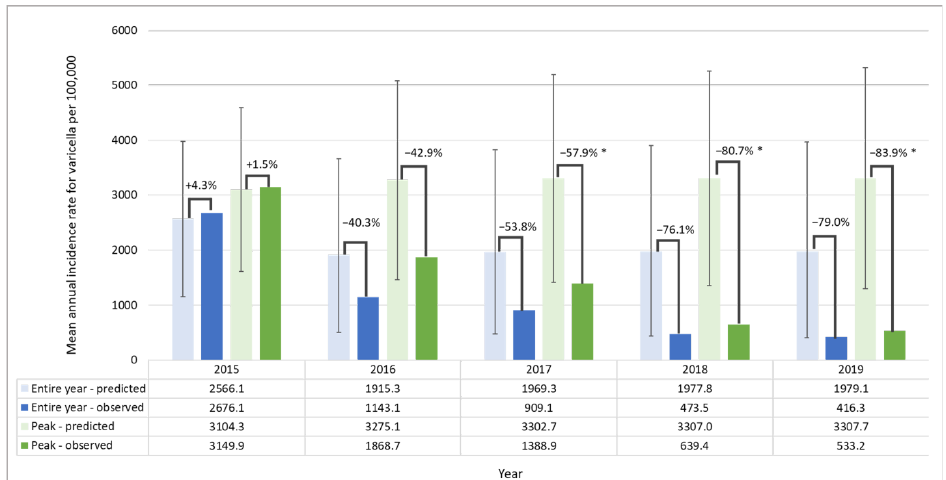
Figure 3. Observed and predicted mean annual incidence rates for varicella in Argentina and relative difference between them, in the entire year and peak periods, in the target population (1–4-year-olds). * Periods where observed values are not within the 95% PI of predicted mean annual incidence rate. Proportion of target population eligible for vaccination: less than 25% in 2015; 25 – 50% in 2016; 50 – 75% in 2017; 75 – 100% in 2018 and 100% in 2019. Vaccination coverage in target population: 44.8% in 2015; 74.4% in 2016; 76.8% in 2017; 81.0% in 2018 and 77.6% in 2019. Non-peak period, all months excluding September to November; observed, observed incidence following UVV introduction; overall period, all months; peak period, September to November; predicted, predicted incidence without UVV introduction; UVV, universal varicella vaccination; PI, prediction intervals.